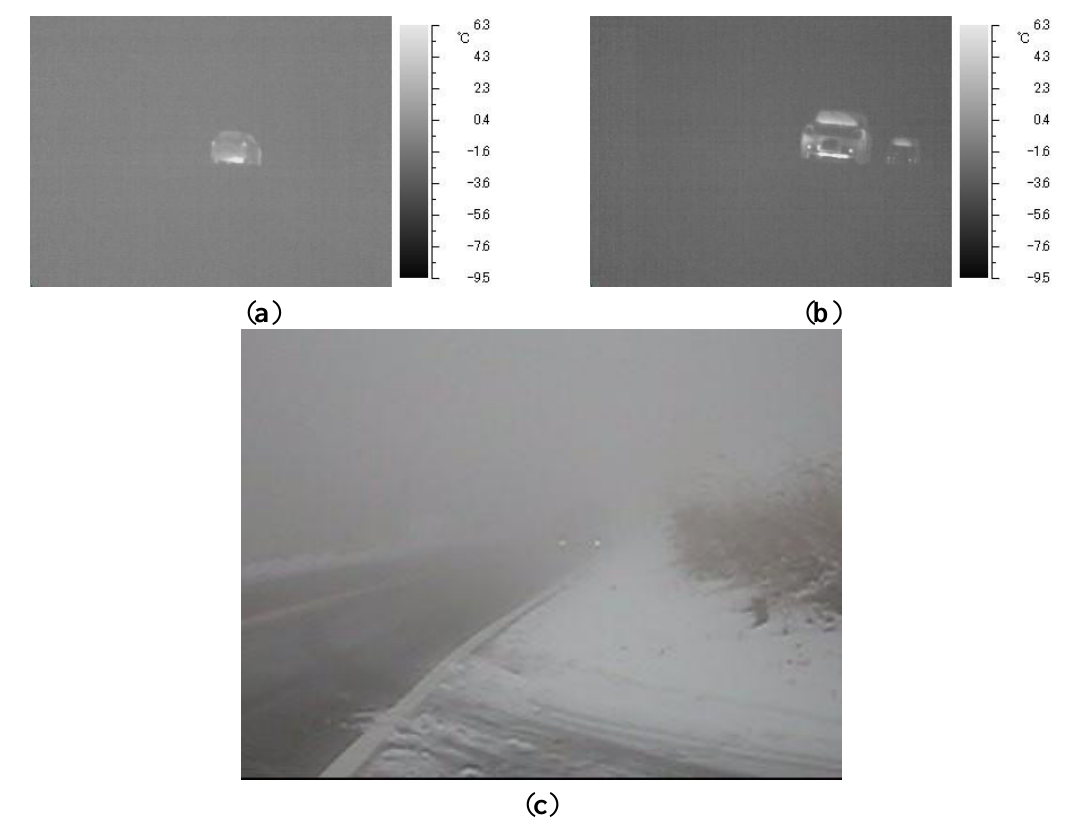
Figure 1. Thermal images and a visible light image in snow and thick fog: ( a ) thermal image (back side view), ( b ) thermal image (front side view), and ( c ) visible light image (front side